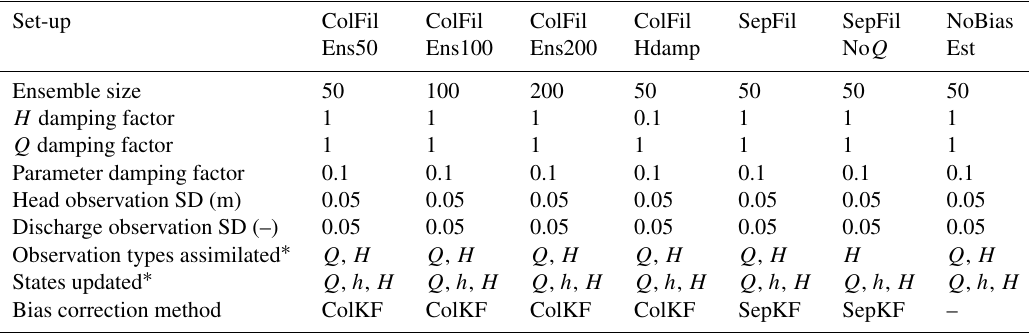
Table 1. Overview of set-ups studied in the synthetic tests. Set-up